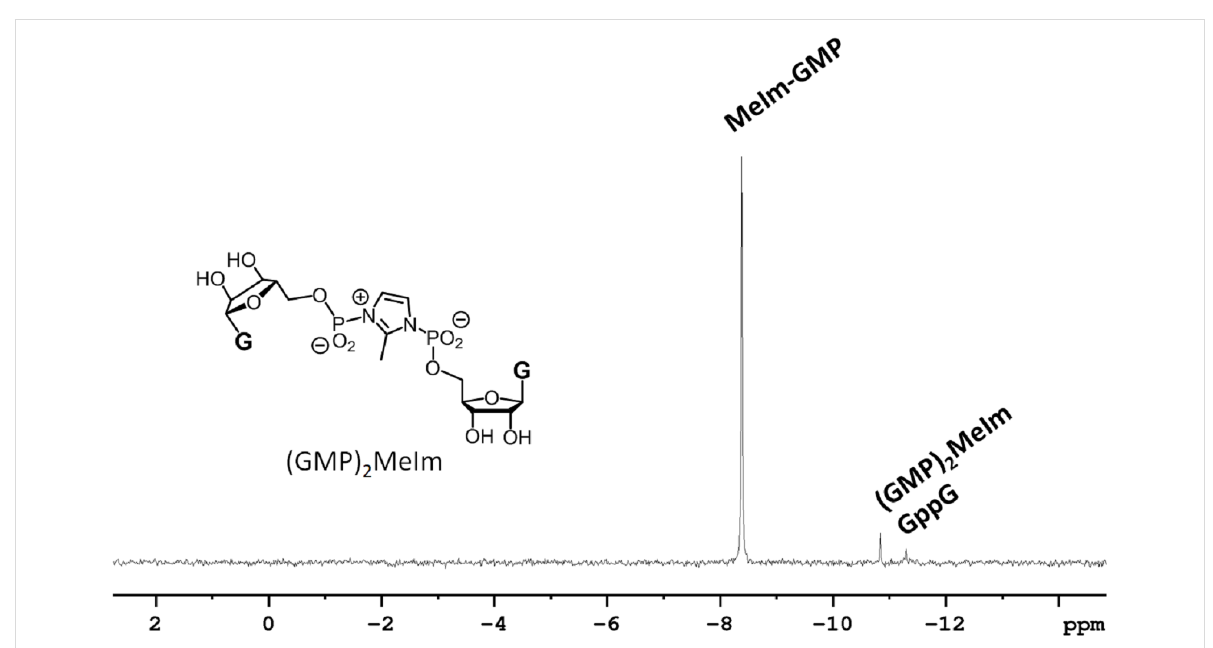
Figure 13: 31 P NMR spectrum (161.9 MHz) of crude MeIm-GMP in D 2 O. The resonance of the imidazolium bisphosphate appears at − 10.8 ppm, and that of the pyrophosphate GppG at − 11.3